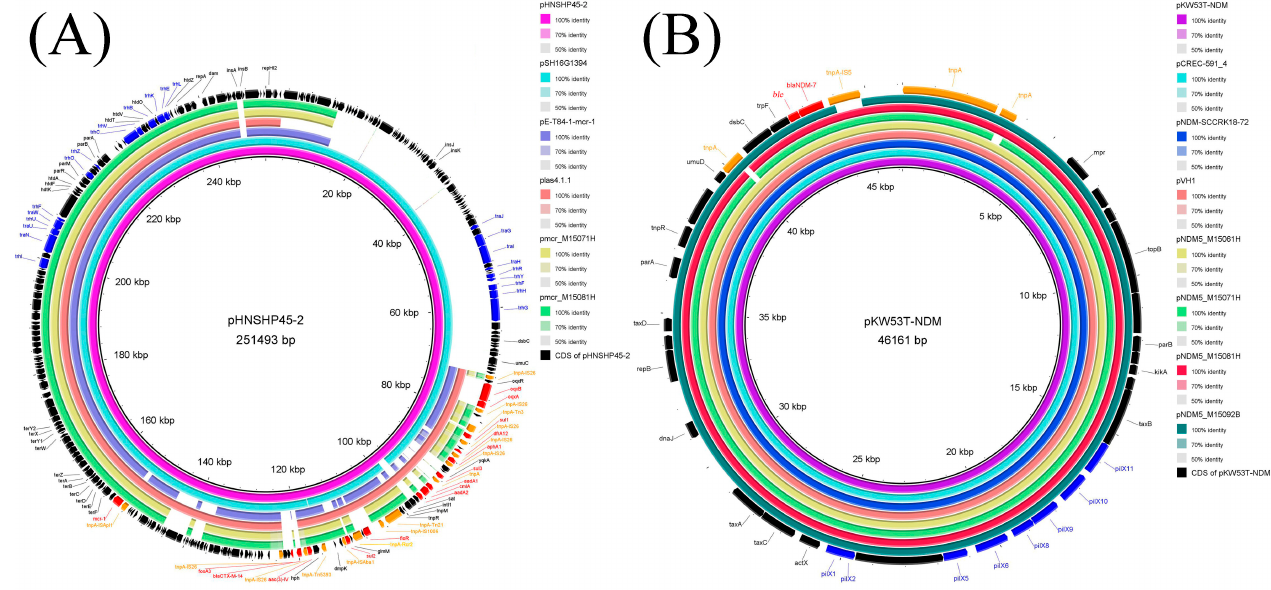
Figure 2. Circular alignment of IncHI2 mcr-1 -bearing ( A ) or IncX3 bla NDM-5 -bearing ( B ) plasmids by BRIG. ( A ) The plasmid pNSHNP45-2 (KU341381) (pink ring) from E. coli in pigs from China was set as a reference. The light blue, blue purple and orange rings represent pH16G1394 (NZ_MK477614) from clinical Salmonella , PE-T81-1- mcr-1 (CP090269) from human E. coli and plas4.1.1 (NZ_CP047116) from Salmonella of chicken, respectively, in China. The yellow and green rings represent pmcr_M15071H and pmcr_M1508H in this study. ( B ) The plasmid pW53T-NDM (KX214669) (purple ring), from a urinary tract infection patient in Kuwait was set as a reference. The light blue, blue and orange rings represent pCREC-591_4 (CP024825) from ascites in a Korean patient, pNDM-SCCRK18-72 (MN565271) in E. coli in swine from China and pVH1 (CP028705) in vegetable-sourced E. coli from China, respectively. The yellow, green, red and dark green rings represent pNDM5_M15061H, pNDM5_M15071H, pNDM5_M15081H and pNDM5_M15092B in this study. The outer circle with black arrows represents annotation of the reference plasmids; among them, the red, blue and orange represent resistance genes, transfer-related genes and transposase genes, respectively.